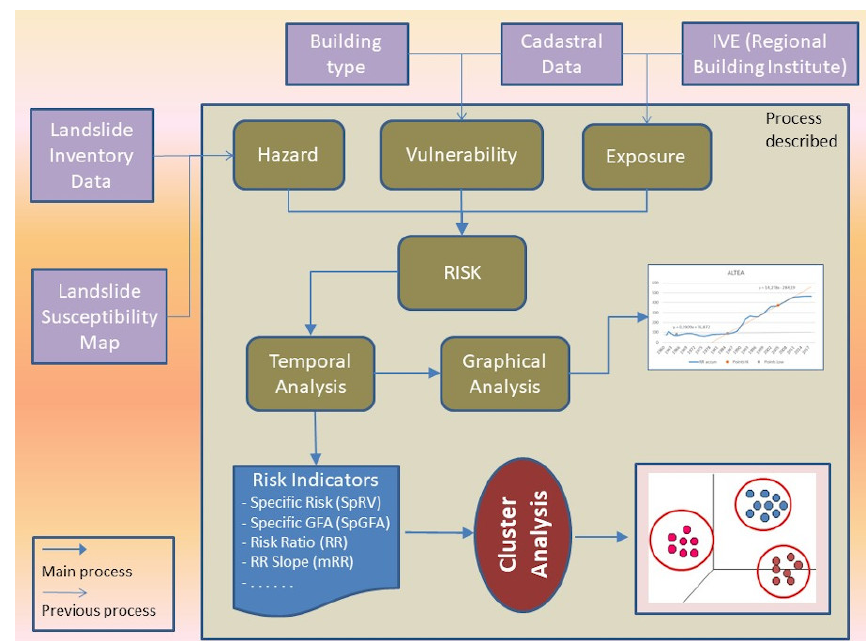
Figure 5. Flow chart of the work